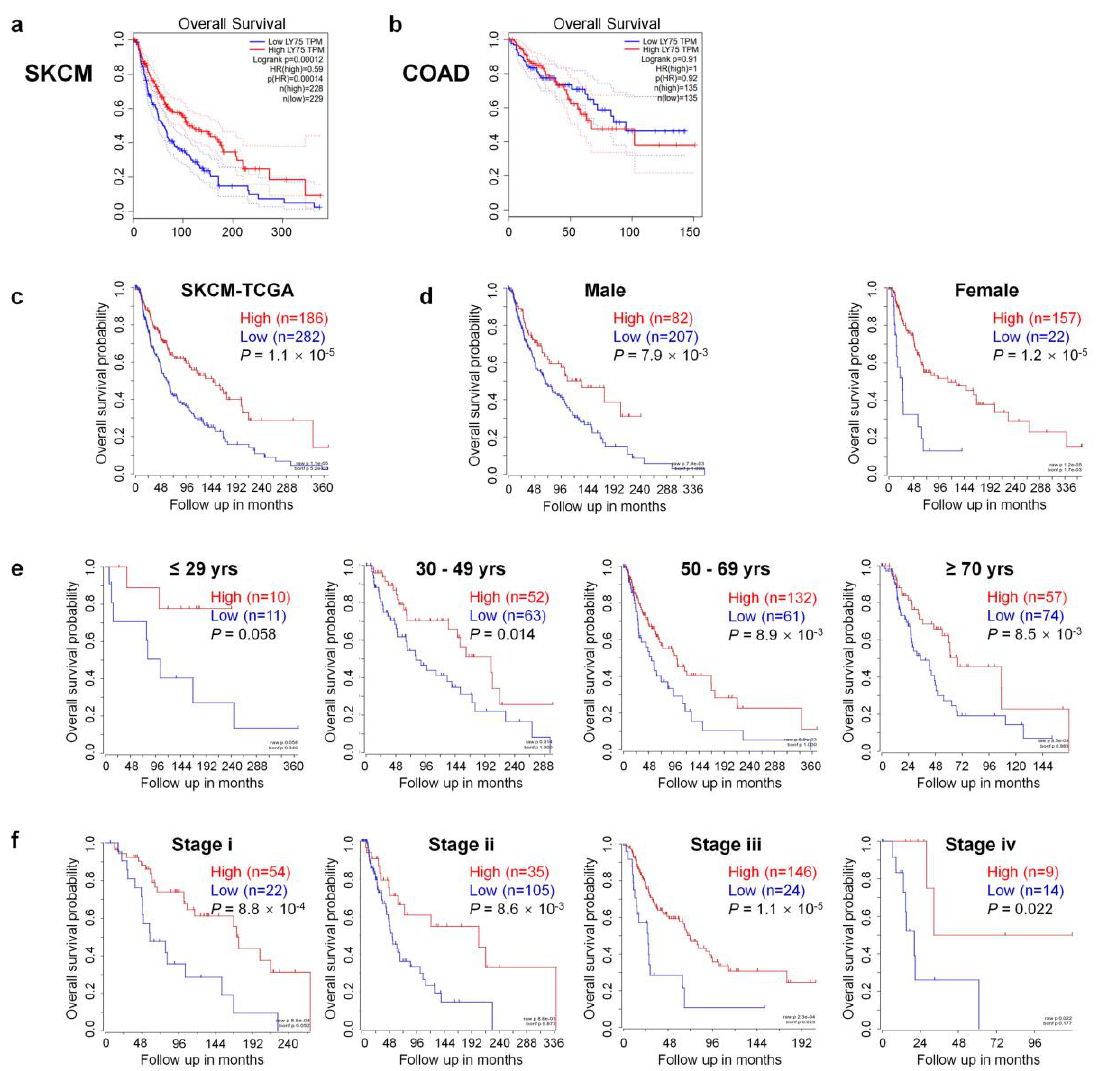
Figure 2. Comparison of overall survival between Ly75 expression high and low patient groups in skin cutaneous melanoma (SKCM) and colon adenocarcinoma (COAD). Kaplan–Meier survival curves of two patient groups that were split by the median value of Ly75 expression were generated from The Cancer Genome Atlas (TCGA) data using the Gene Expression Profiling Analysis (GEPIA) web tool for ( a ) skin cutaneous melanoma (SKCM) and ( b ) colon adenocarcinoma (COAD). The log-rank p -value, Cox proportionalhazardratio(HR), p -valueofHR,andnumberofpatientsineachanalysisgroupwereshown on graph. Moreover, 95% confidence interval was marked with dotted lines. Kaplan–Meier survival curvesoftwopatientgroupsthatweresplitby Ly75 expressionwiththescan-cut-o ff -moduswerescanned by R2: Genomics Analysis and Visualization Platform (https: // hgserver1.amc.nl / cgi-bin / r2 / main.cgi) with the ( c ) SKCM-TCGA dataset ( n = 470) and its subgroups divided by ( d ) gender, ( e ) age, and ( f ) tumor stage (only in stage i, ii, iii,